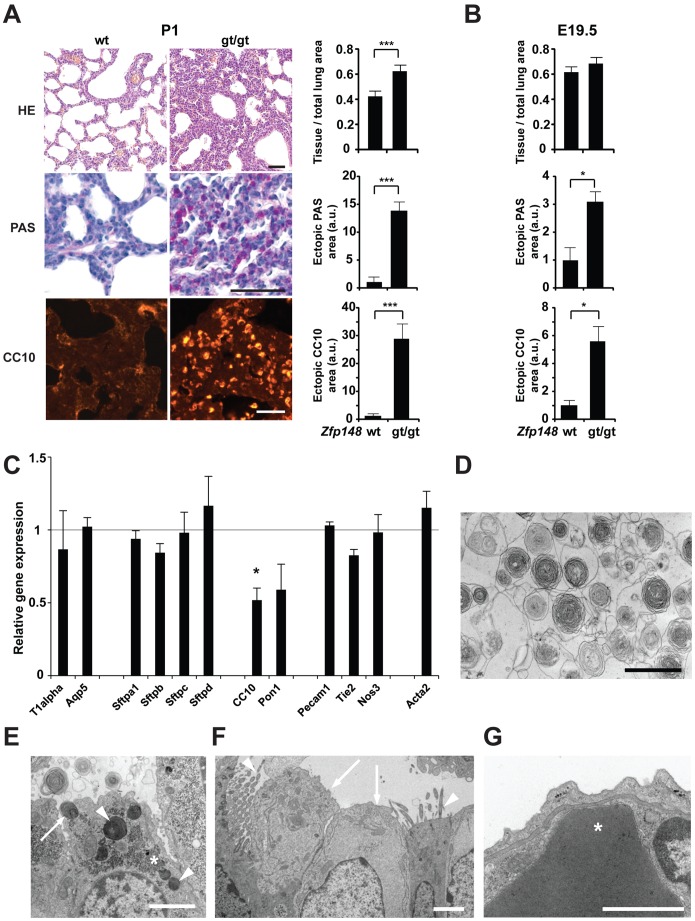

Zfp148 deficiency prevented structural maturation of prenatal lungs without effecting epithelial cell differentiation or surfactant production.(A) Photomicrographs showing lung morphology (hematoxylin and eosin; HE) and glycogen content (periodic acid-Shiff; PAS) and CC10 immunofluorescence in P1 lungs from Zfp148gt/gt and wt mice, respectively. (A, B) Graphs show quantification (n = 6) of mean tissue area per total lung area, PAS-positive area with bronchioles excluded, and CC10-positive area with bronchioles excluded in (A) P1 and (B) E19.5 lungs from wt and Zfp148gt/gt mice. a.u., arbitrary units. (C) Real-time RT-PCR showing relative expression levels of markers for type I (T1alpha, Aqp5), type II (Sftpa1, Sftpb, Sftpc, Sftpd), clara (CC-10, Pon1), endothelial (Pecam1, Tie2, Nos3) and smooth muscle (Acta2) cells in Zfp148gt/gt lungs compared to wt at P1 (n = 6). Wt means are represented by the horizontal straight line at 1. (D) Transmission electron microscope (TEM) image of Zfp148gt/gt lung at E18.5–19.5 showing lamellar bodies secreted into the lumen of a terminal sac. (E–G) TEM images showing differentiated cells in Zfp148gt/gt lungs at E18.5–19.5. (E) Apical part of an alveolar type II cell containing typical lamellar bodies (arrowheads), one of which is in the process of exocytosis (arrow), and accumulations of densely contrasted glycogen particles (asterisk). (F) Two ciliated cells (arrowheads) surrounding two Clara cells (arrows) with bulging appearance and mitochondria accumulated in the apical cytoplasm. (G) High power view of the blood-alveolar barrier showing an erythrocyte (asterisk) in close contact with a highly attenuated part of an endothelial cell that shares a basal lamina with the alveolar type I cell. Scale bars, 2 µm. *P<0.05, ***P<0.001.